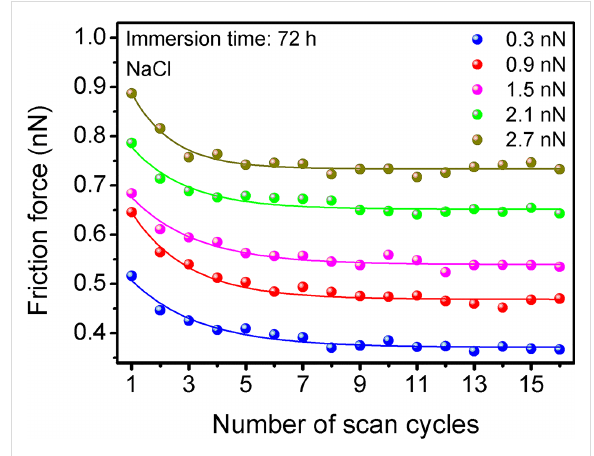
Figure 2: Friction force as a function of number of scan cycles on Zr 63 Ni 22 Ti 15 metallic glass after immersion into 0.2 M NaCl solution for 72 h. The smooth curves are fits of the data to an exponential decay